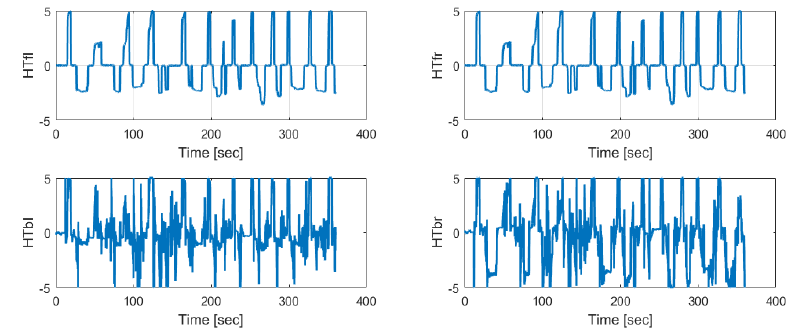
Figure 11. Control inputs for four of horizontal thrusters in the maximum forward speed